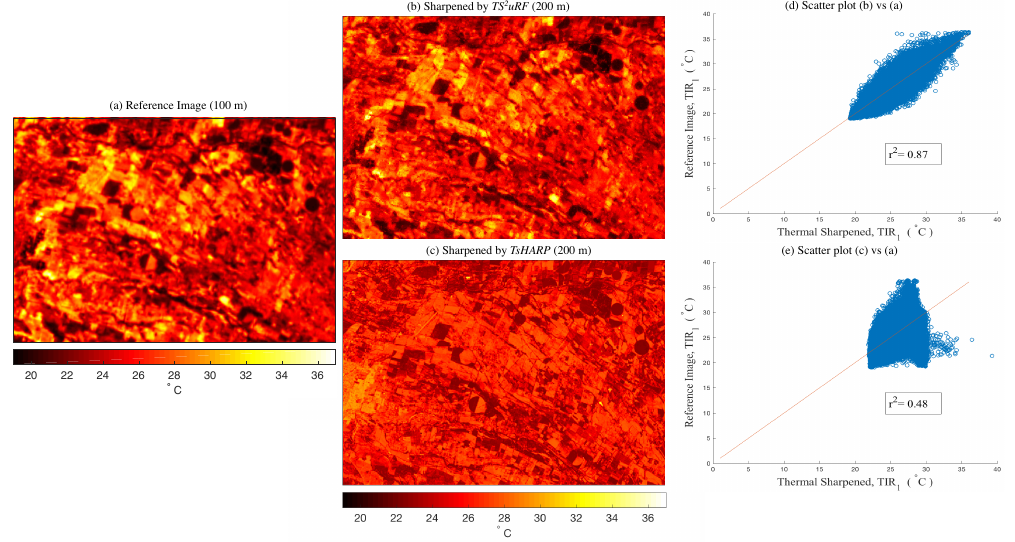
Figure 8. Comparison between ( a ) the reference image TIR 1 ; ( b ) TIR 1 sharpened by TS 2 uRF and ( c ) TIR 1 sharpened by TsHARP; ( d ) Scatter plot between reference image ( a , b ) sharpened image by TS 2 uRF; ( e ) Scatter plot between reference image ( a , c ) sharpened image by